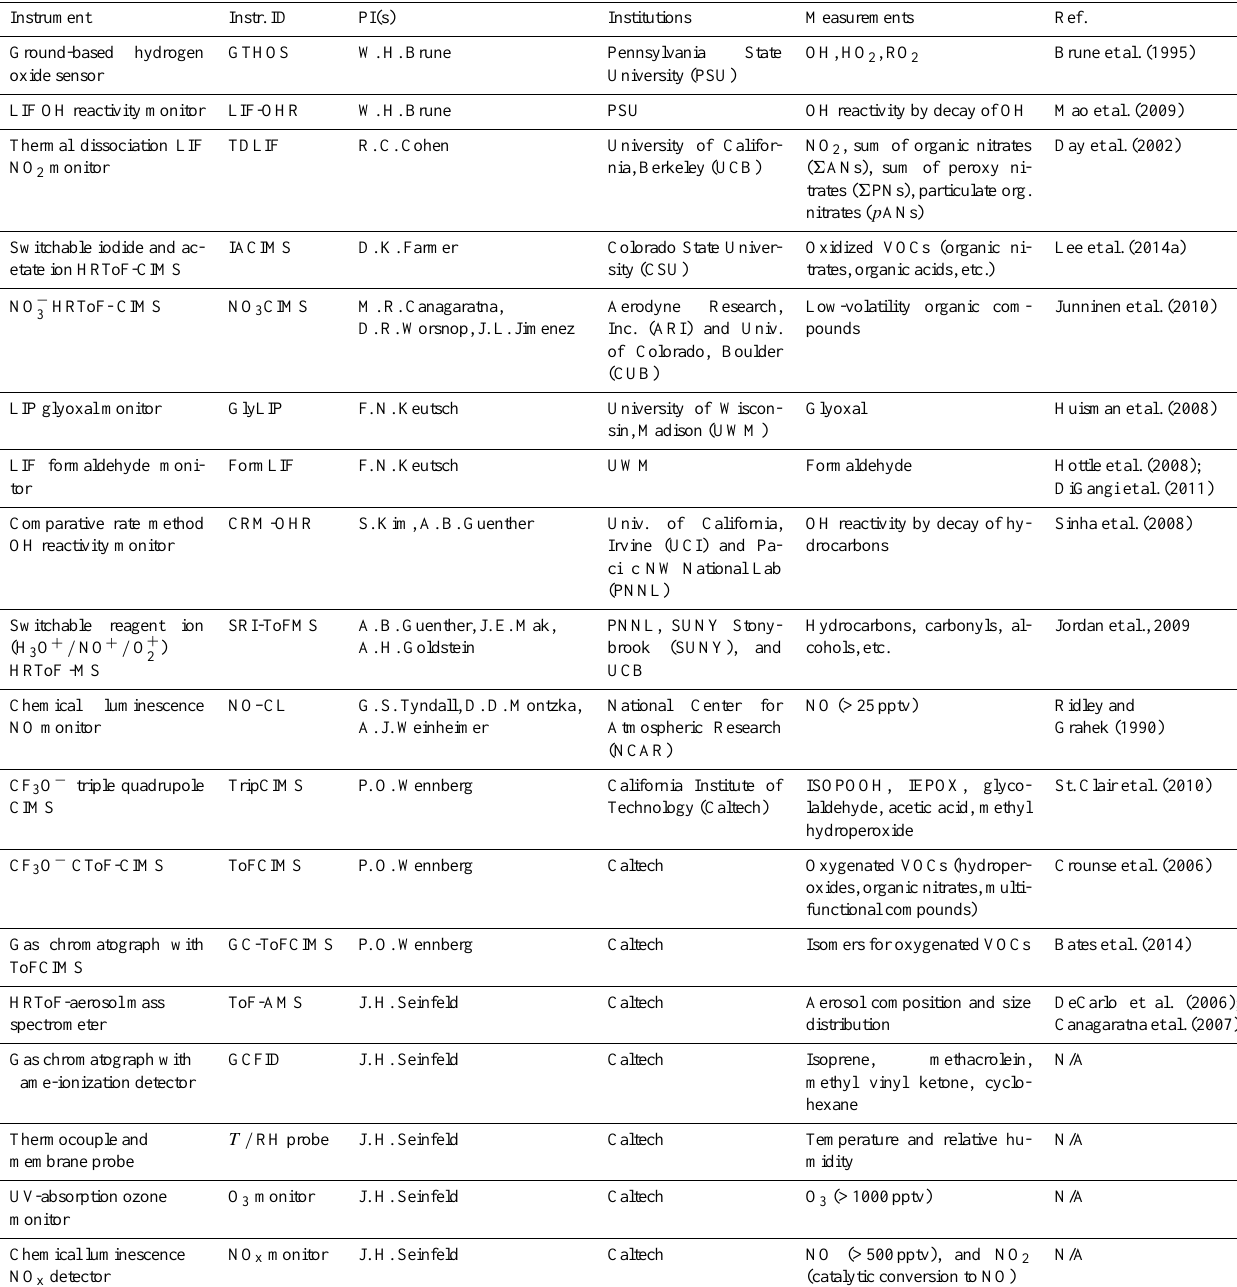
Table 1. List of participating instruments, principle investigators (PIs), and institutions. Key acronyms: laser-induced fluorescence (LIF), laser-induced phosphorescence (LIP), high-resolution time-of-flight (HRToF), compact time-of-flight (CToF), MS (mass spectrometer), and CIMS (chemical ionization mass